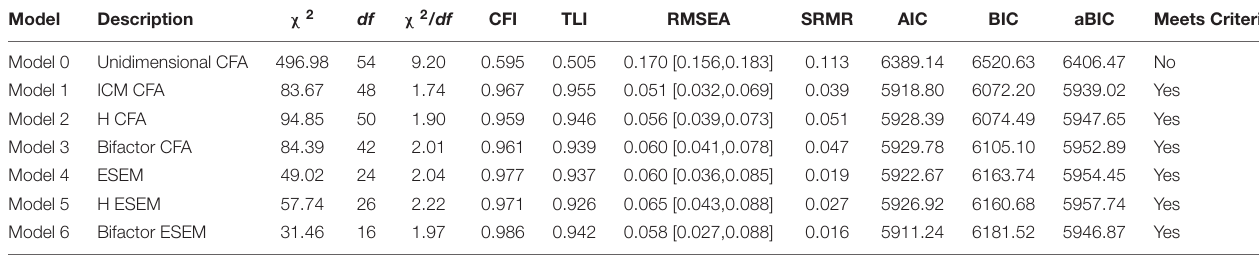
TABLE 2 | Goodness-of-fit statistics for the models estimated on the SOAR